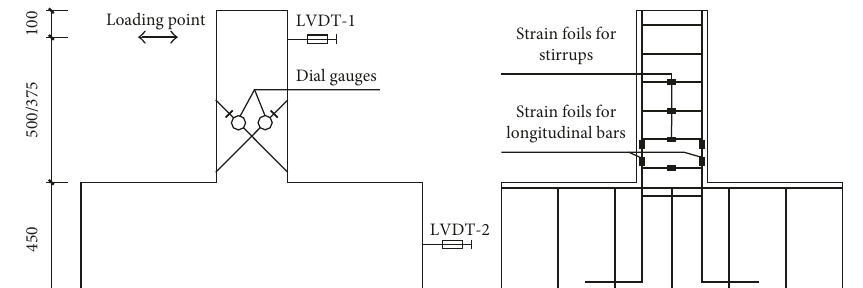
Figure 4: Loading